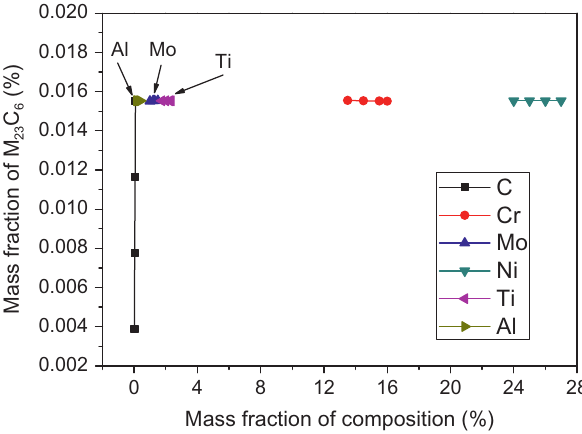
Figure 18: Influence of different elements on maximum amount of M 23 C 6